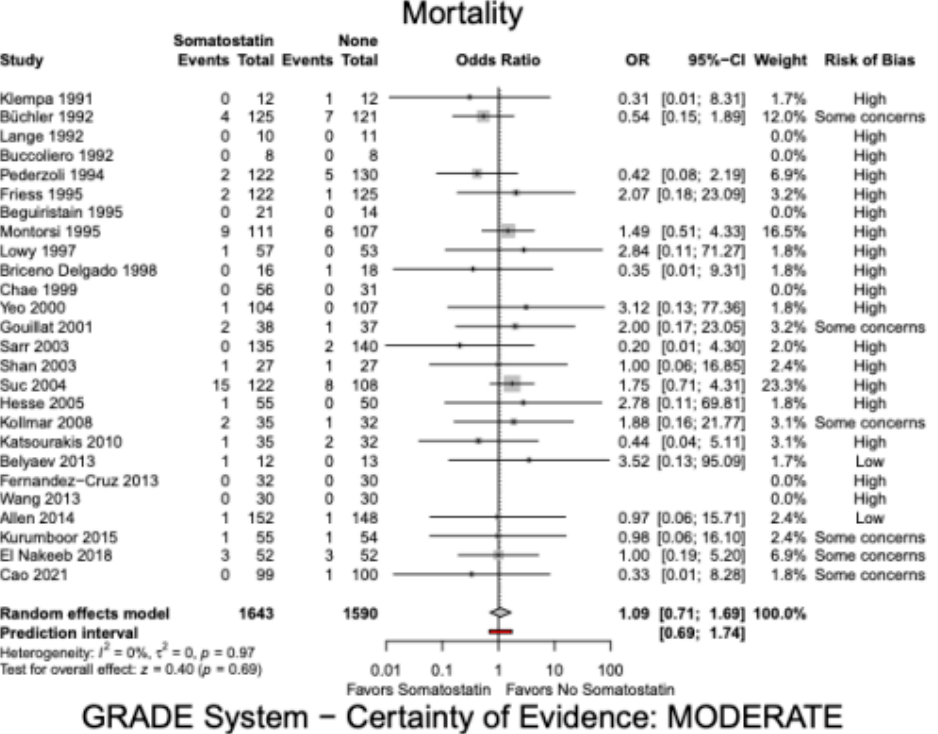
Figure 2. Mortality Somatostatin analogues.